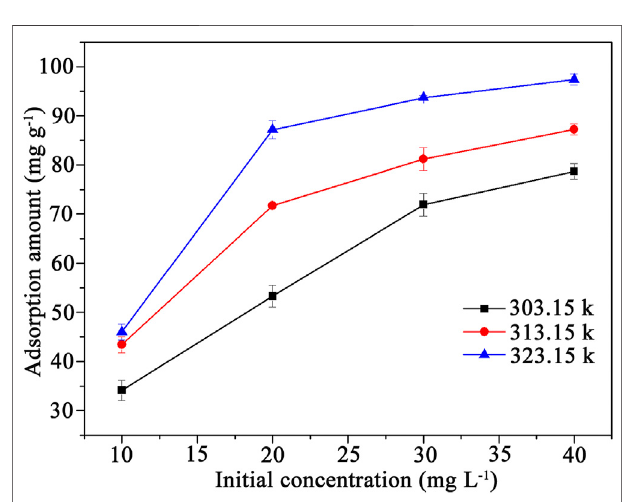
FIGURE6| Effectoftemperature ontheadsorption amountofPO 43 − on La 2 (CO 3 ) 3 , pH: